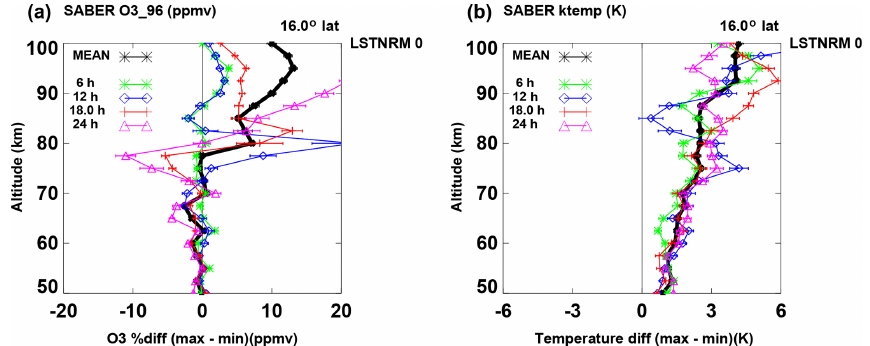
Figure 6. Ozone (a) and temperature (b) responses from 50 to 100km at 16 ◦ N. Values are responses at solar max minus responses at solar min for ozone (%/100sfu) and for temperature (K/100sfu). Black asterisks denote responses based on zonal means that are averages over both longitude and local time, green asterisks denote our responses based on zonal means fixed at 6LST, blue diamonds represent zonal means fixed at 12LST, red plusses represent zonal means fixed at 18LST, and magenta triangles represent zonal means fixed at 24LST, based on SABER data.